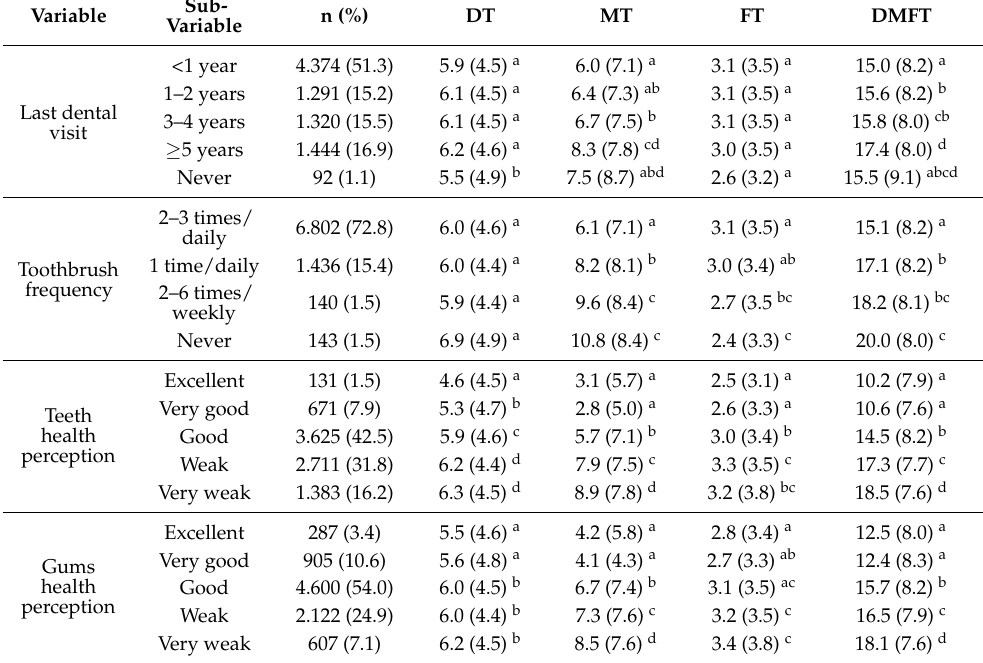
Table 4. Oral health care and self-reported perception about oral health condition (n =